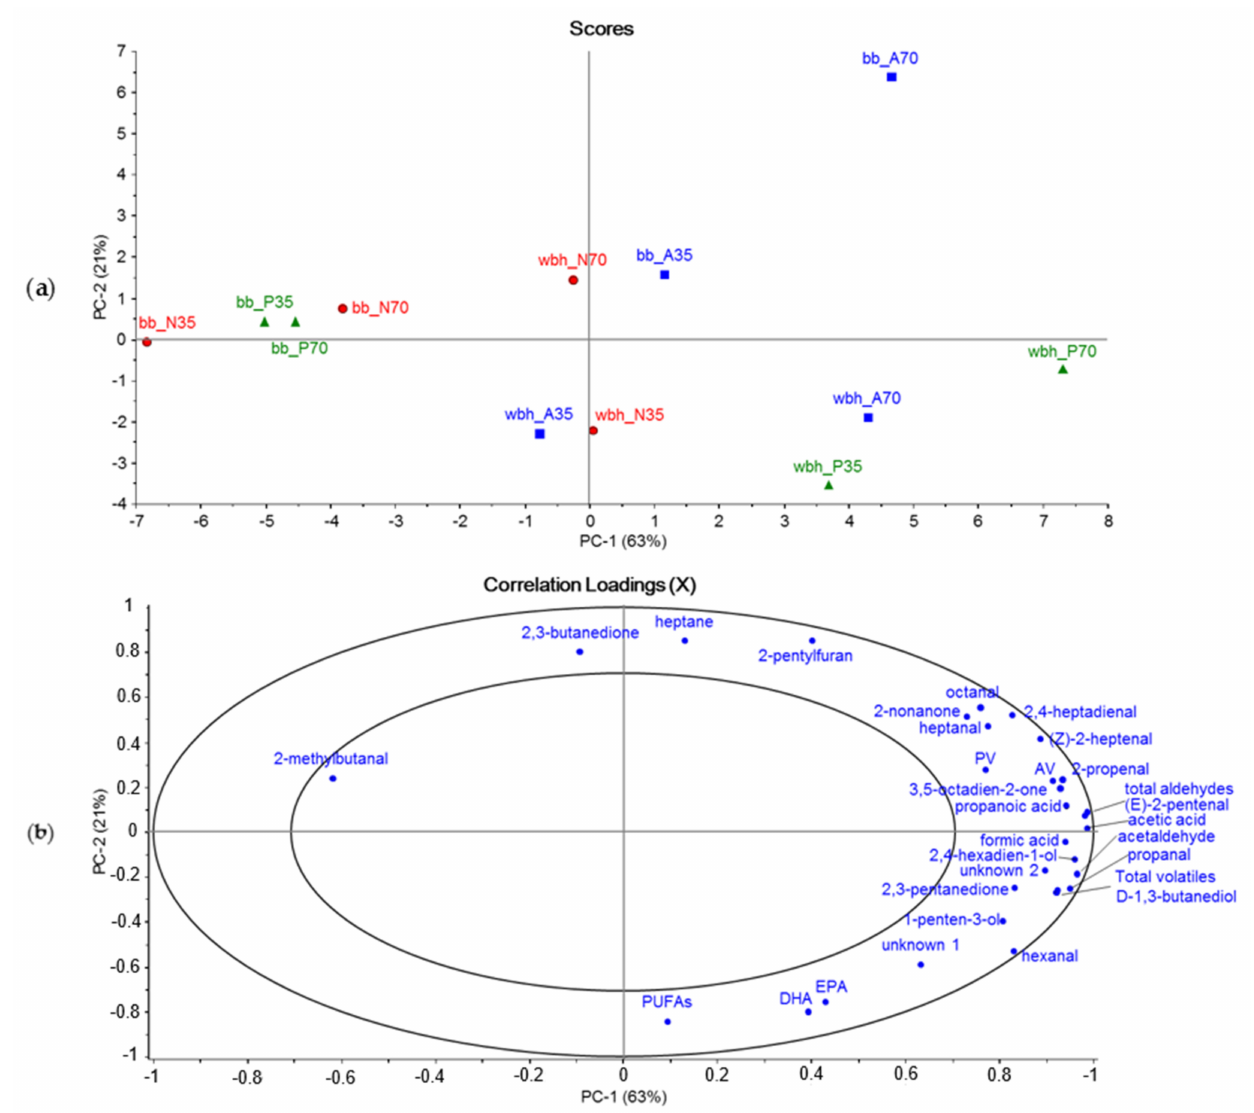
Figure 3. Principal component analysis (PCA) of volatile compounds that were most influential in PCAs with all identified volatiles, total volatile and aldehyde peak areas, EPA, DHA and PUFA contents, and AVs and PVs. Both raw materials were analyzed together and marked to the figures as bb (by-products) and wbh (whole Baltic herring). The enzymes are marked as their initials: A for Alcalase, N for Neutrase and P for Protamex. The figures are ( a ) scores plot and ( b ) correlation loadings of principal components PC1 and PC2. The data was normalized (auto normalization) and centered (mean